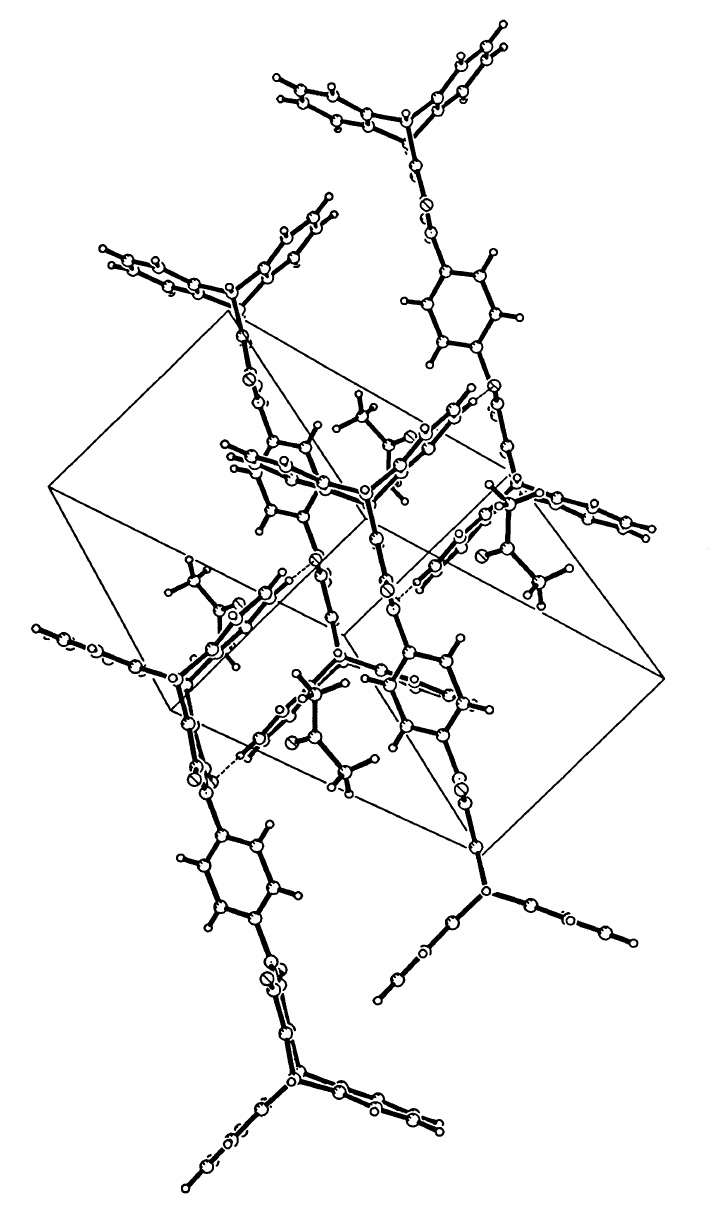
Figure 2. View of the crystal packing of 8